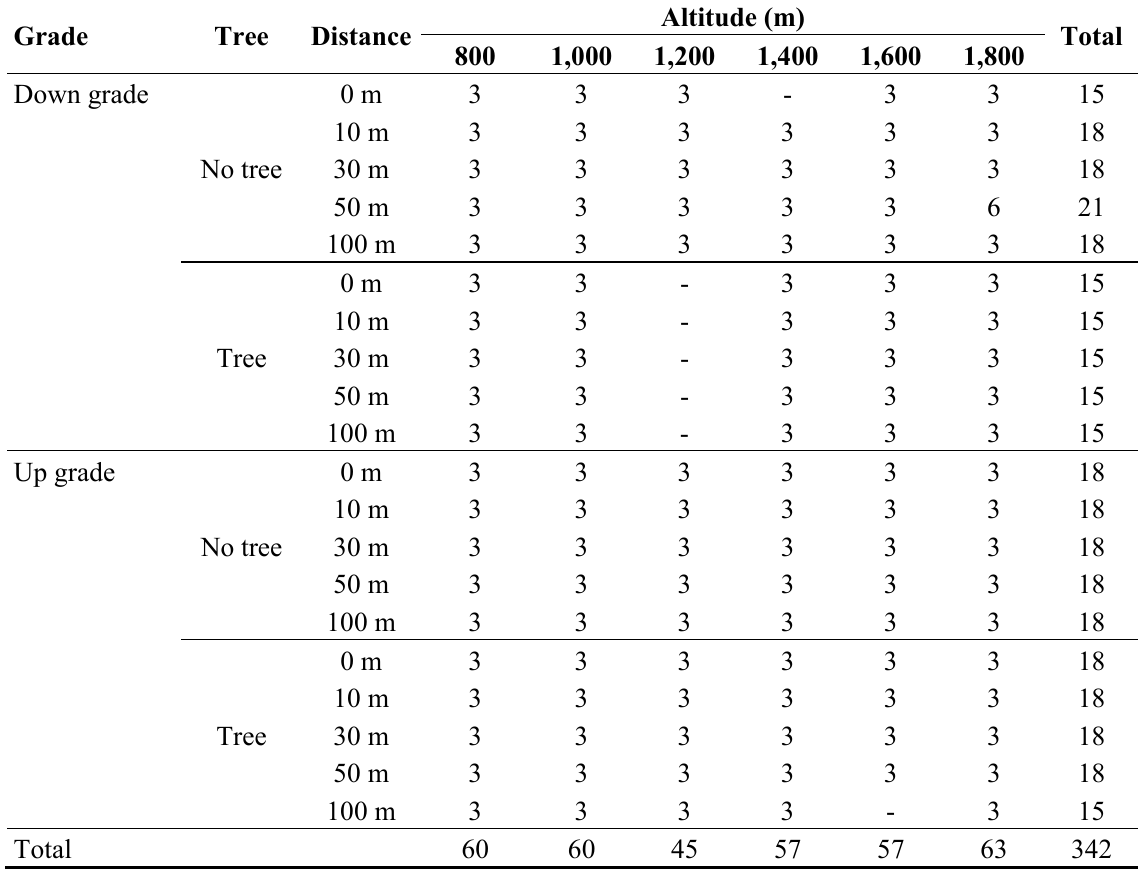
Table 2. Sample distribution cross-tabulation by Altitude × Distance × Tree × Terrain.